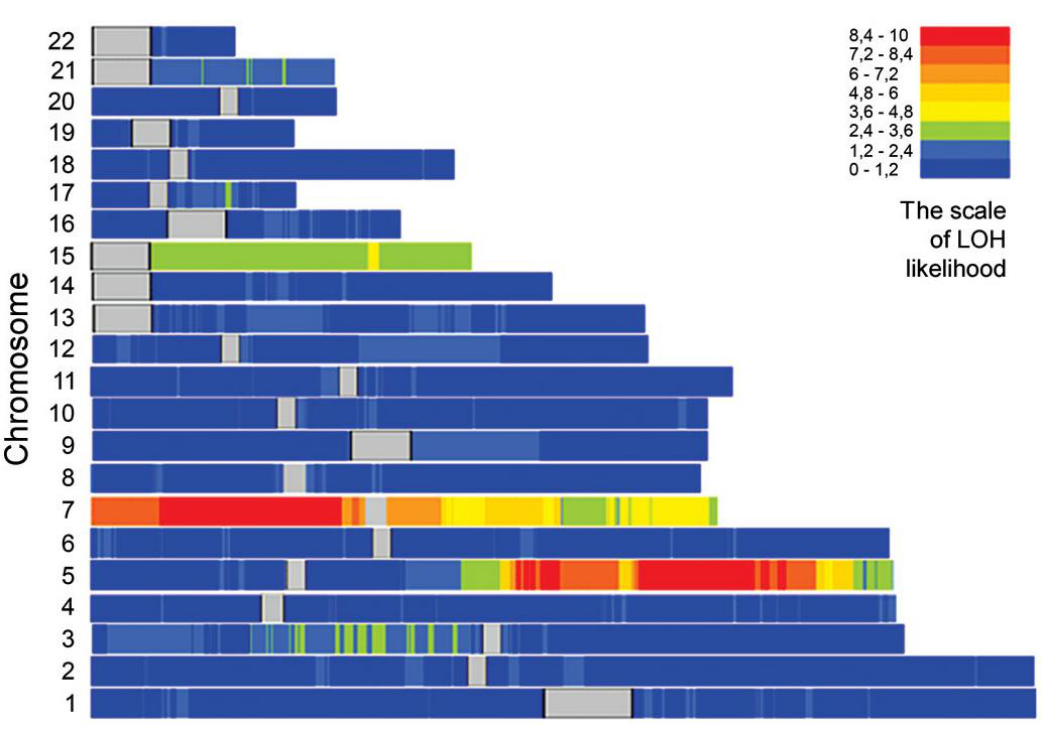
Figure 1. The pattern of genome-wide LOH score derived by SNP arrays in set of 19 radiation-associated AML samples. The average of LOH-likelihood values ranges from blue (lowest probability) to red (highest probability). Centromeres are indicated with